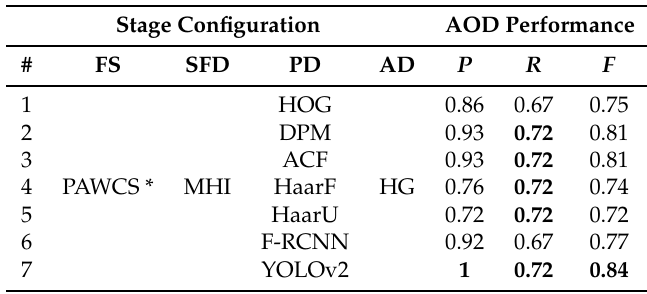
Table 8. Results comparing people detectors for AOD performance. Bold indicates the best results. Key: FS = Foreground Segmentation. SFD = Stationary Foreground Detection. PD = Pedestrian Detection.